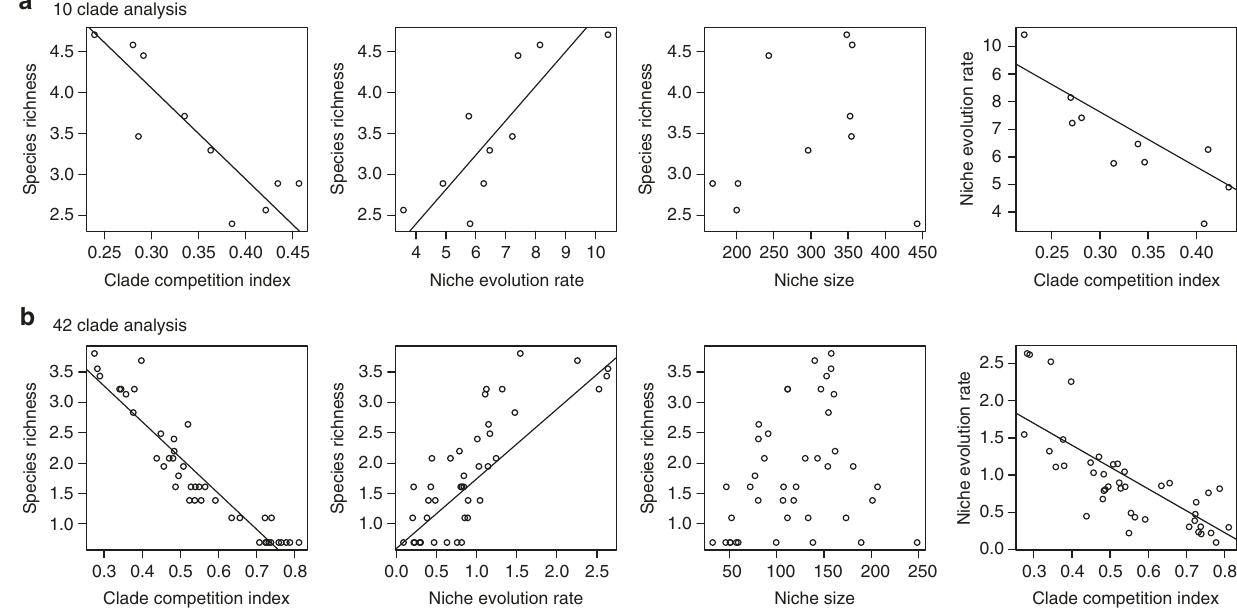
Fig. 2 Associations between species richness and diversi fi cation metrics. Scatter plots between clade species richness and selected clade metrics for two divisions of the conifer phylogeny into a 10 large clades and b 42 smaller clades. Straight lines indicate signi fi cant linear effects detected using phylogenetic generalized least squares (PGLS) regressions. The presence of multiple correlations made interpretation dif fi cult; for this reason, we performed a path analysis (Fig. 3)